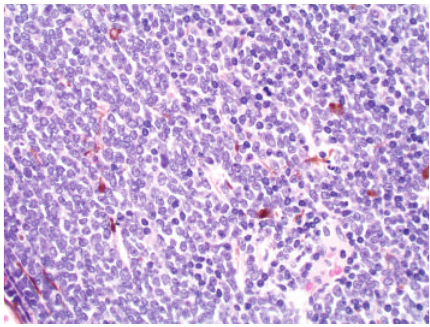
Figure 3: Sheets of monotonous mononuclear blast cells (H&E, magnification ×